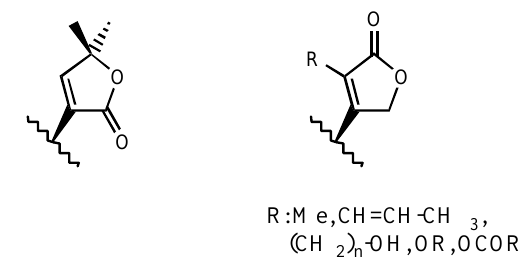
Figure 11. Semisynthetic derivatives with lactone ring